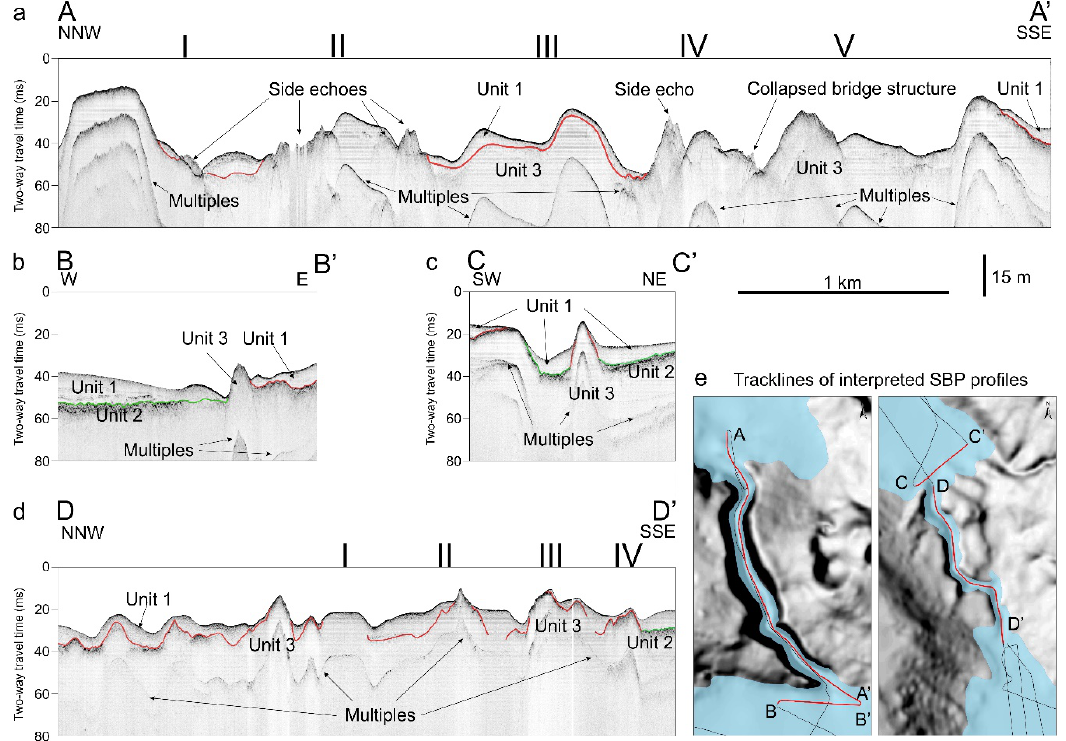
Figure 8. High-resolution seismic profiles surveyed in the canyons. ( a ) Profile A–A ′ . Only a thin sediment cover was visible over the karstified NZD seabed with multiple side echoes. A thicker sediment succession was visible at the channel ends and in the central part. ( b ) Profile B–B ′ . A thicker sedimentary succession with two distinct units was visible at the southern NZD end. ( c ) Profile C–C ′ . The northern end of the KZD with a thicker sediment succession. ( d ) Profile D–D ′ . The northern part of KZD was covered with sediment (unit 1); in the southern half, rocky barriers stood out with sediment infill between them. ( e ) The SBP track lines of the interpreted profiles are marked with red lines on the maps. The barriers from Figures 2 and 3 are marked with Roman letters.